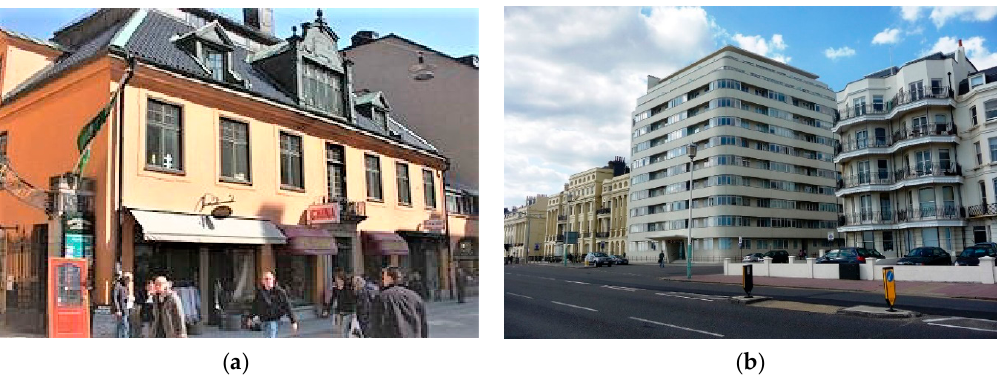
Figure 2. ( a) Example of commercial bottom floors, encouraging mobility, encountersand commerce. ( b) Example of residential bottom floors, creating anonymous, empty surroundings (Photos: PDM).